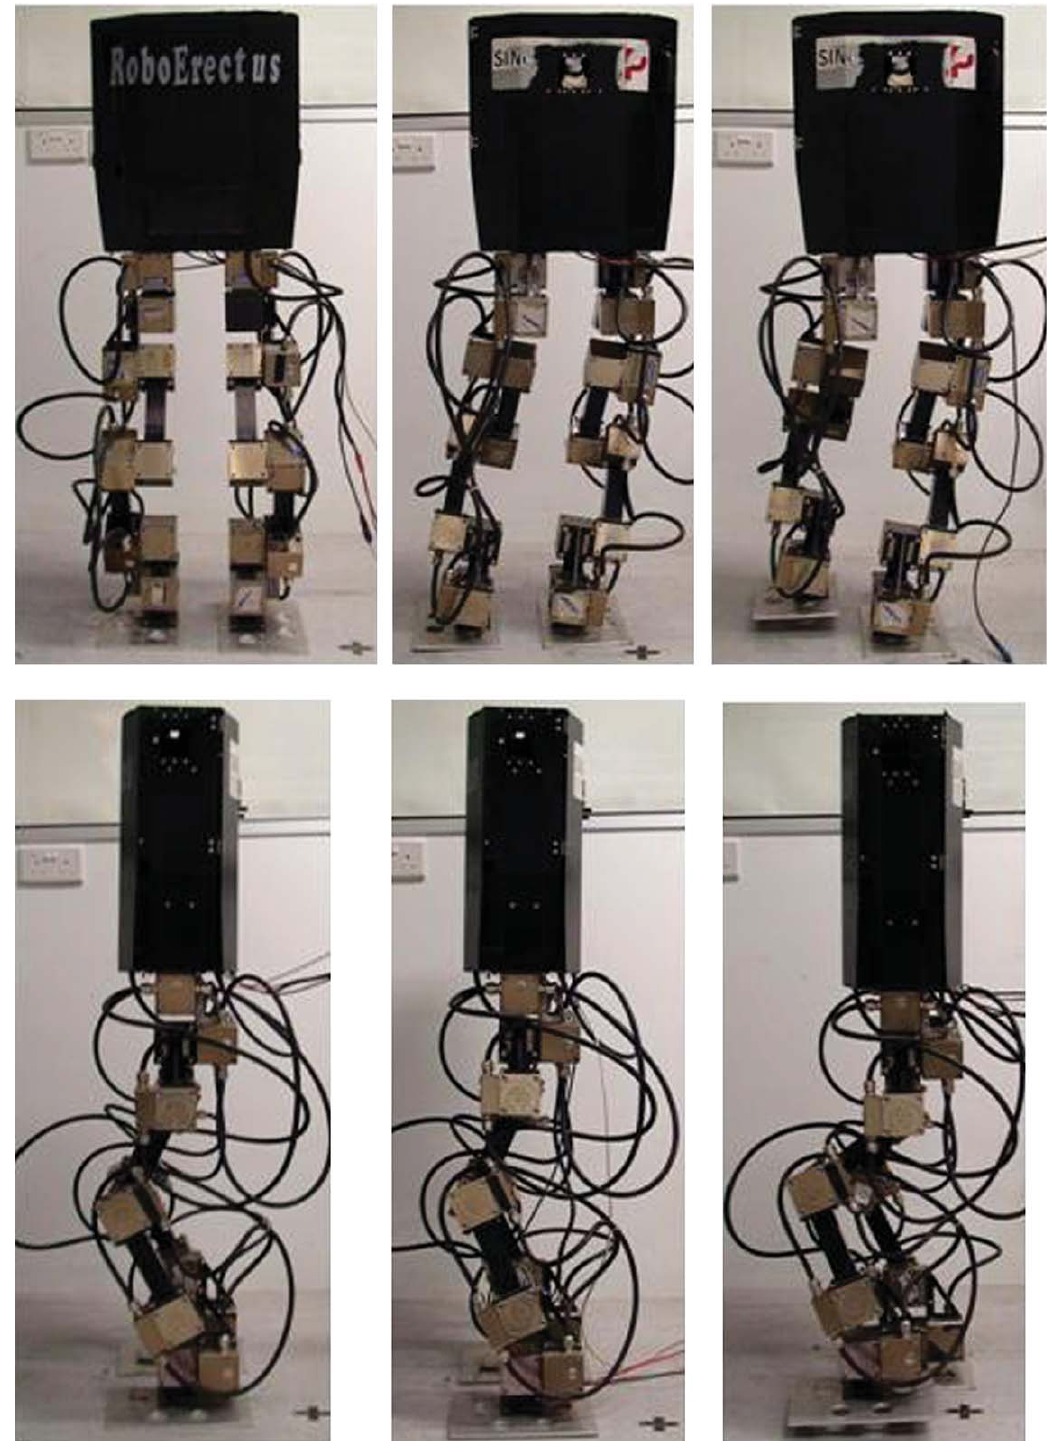
Fig. 8. (a) Idle state (b) State 0 (c) State